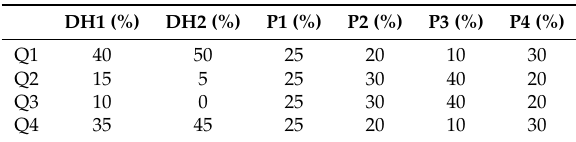
Table 1. Distribution profiles for the district heating (DH) demand and excess heat from processes (P) over one year in